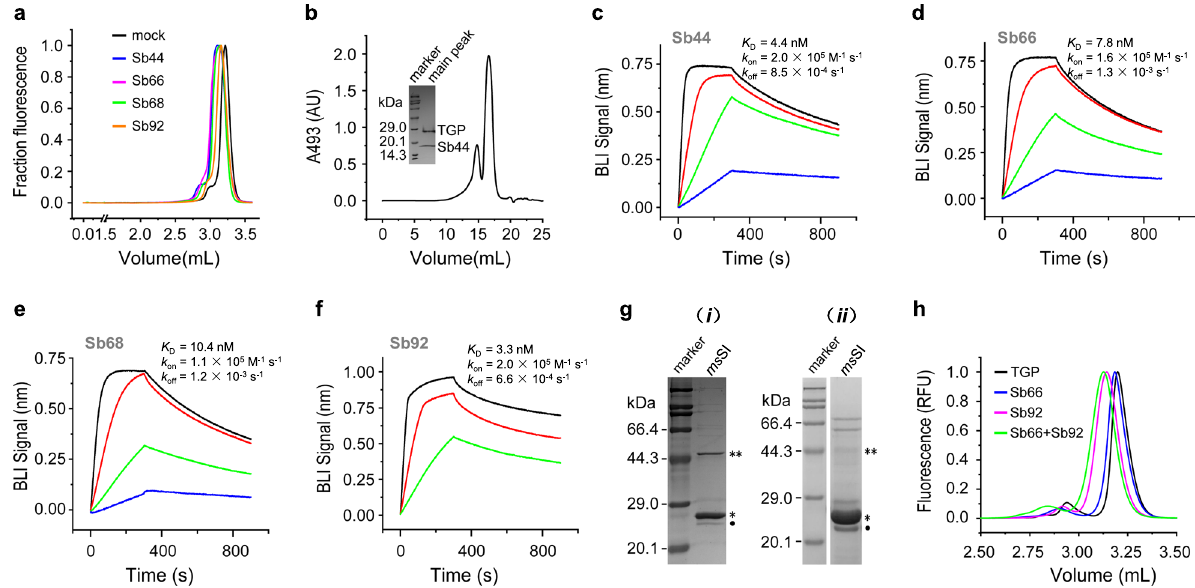
Fig. 7 Characterization of TGP-binding sybodies. a Identi fi cation of TGP binders using FSEC. Four TGP binders (Sb44, blue; Sb66, magenta; Sb68, green; and Sb92, orange), but not a binder for the unrelated maltose-binding protein 59 (mock, black), caused earlier elution of TGP. b SEC of TGP-Sb44 with absorbance detection at 493 nm. Inset shows the SDS-PAGE of the main-peak fraction. c – f Biolayer interferometry (BLI) assay for binding kinetics with TGP immobilized and sybodies as analyte at 7.4 (blue), 22 (green), 66 (red), and 200 nM (black) concentrations. g Af fi nity puri fi cation of ms SI using conjugated Sb44 ( i ) and immobilized metal af fi nity chromatography ( ii ). An asterisk indicates ms SI at 27.1 kDa; A double asterisk indicates possible ms SI dimer. The apparent molecular weight of ms SI was slightly smaller than the theoretical value (30.0 kDa), a phenomenon frequently observed for hydrophobic membrane proteins and other sterol isomerase homologs 14,64,91 . The faint band below ms SI (dot) was residual 3C protease. Other bands were probably contaminants. h FSEC of TGP in the absence (black) or in the presence of Sb66 (blue), Sb92 (magenta), or both sybodies (green). FSEC fl uorescence-detection size exclusion chromatography, GFP green fl uorescent protein, sybody synthetic nanobody, TGP thermostable